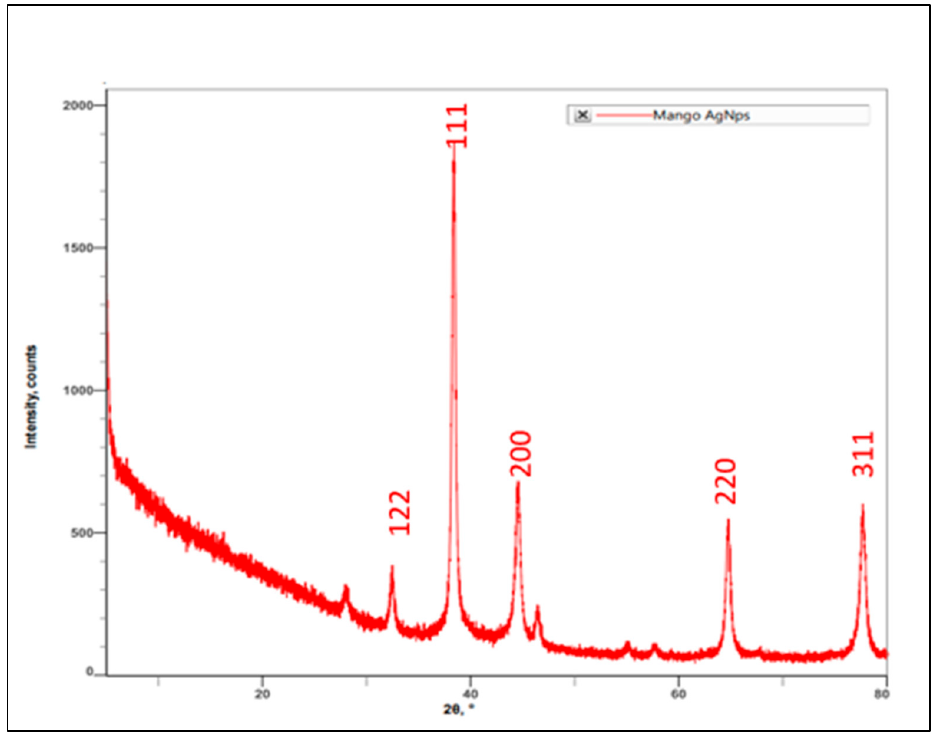
Figure 4. XRD graph of green synthesized AgNPs using M. indica aqu eous leaf extract.